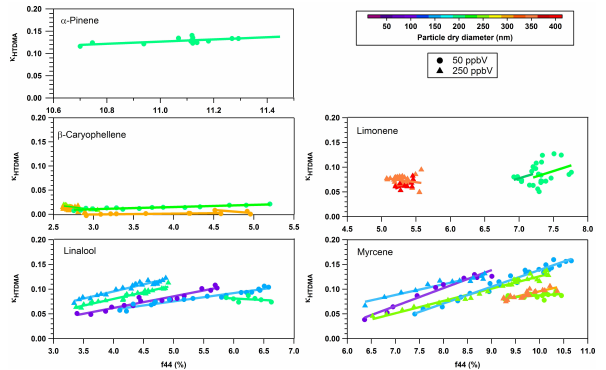
Fig. 10. The relationship between sub- and super-saturated water uptake of SOA particles and their level of oxidation. The κ HTDMA (open symbols) and κ CCN (filled symbols) are mean values mea- sured for the largest size during the final hour of each experiment. The level of oxidation is inferred from the mean values of f 44 dur- ing the corresponding period. The variability bars are ( ± 3s.d.) of the